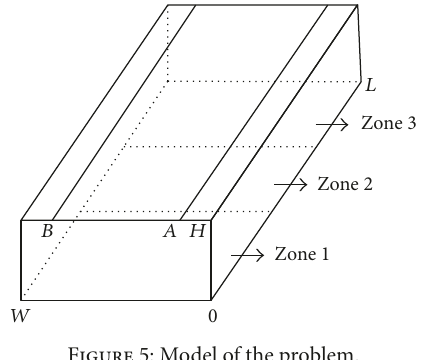
Figure 5: Model of the